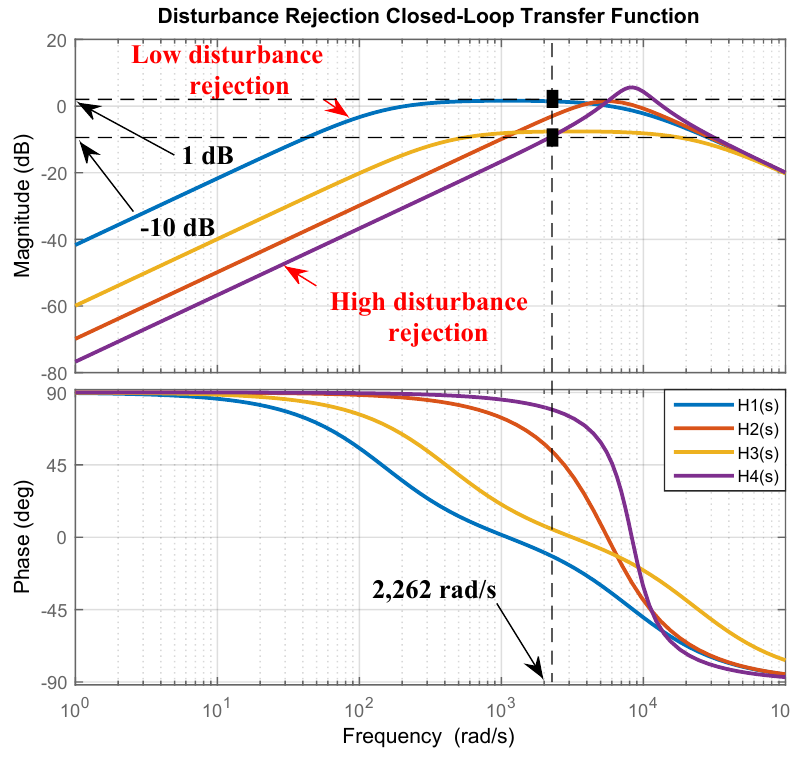
Figure 8. Bode plot of the disturbance rejection closed-loop transfer function.